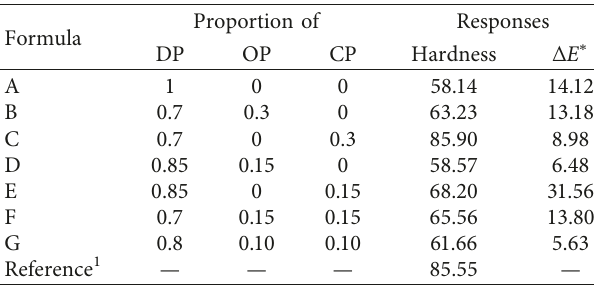
0 (softer) to 100 (harder), and (2) the total color difference Δ E ∗ measured in the CIELab system using a CM chro- mameter 2500d Minolta(Japan): L ∗ � whiteness (0: com- pletely black; 100: completely transparent), a ∗ ( − 60: green; 60: red), and b ∗ ( − 60: blue; 60: yellow). Δ E ∗ indicates the